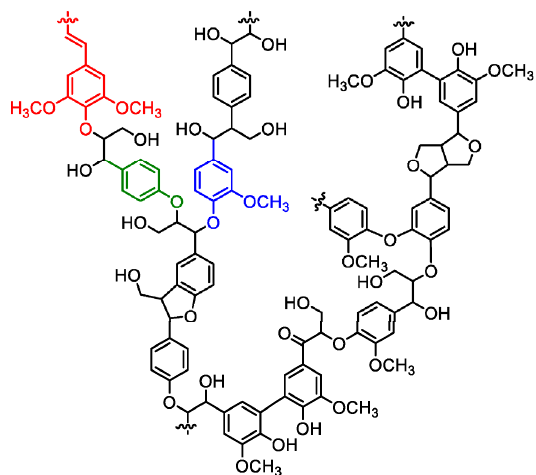
Figure 8. Chemical structure of lignin (Major monolignol units are colored: sinapyl alcohol—red, guaiacyl alcohol—blue, and p-coumaryl alcohol—green) [135].